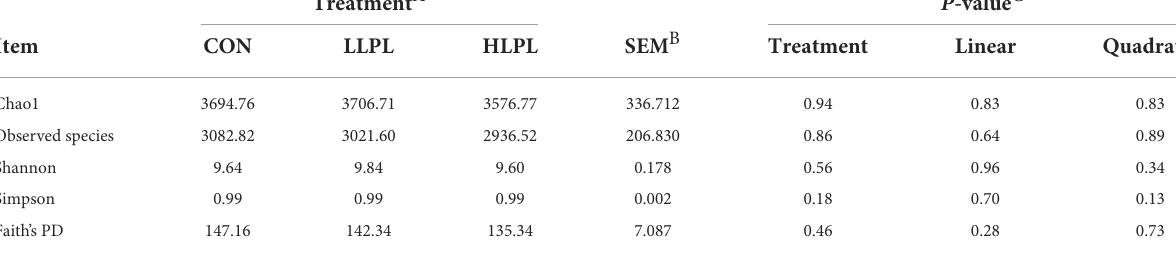
TABLE 4 Effect of dietary lysophospholipids supplementation on Alpha diversity index of fecal bacteria.